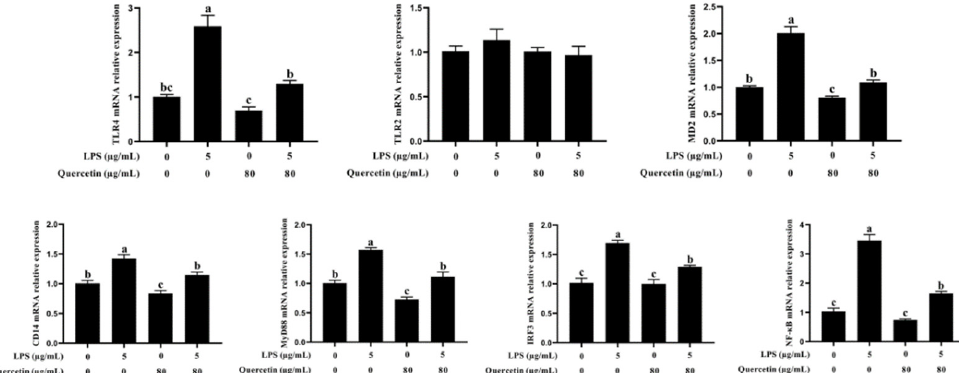
Figure 6. Influence of quercetin on the TLR4 signalling system in LPS-induced BIECs. BIECs were treated with 80 µ g/mL quercetin in an environment of 5 µ g/mL LPS for 6 h. The mRNA expressions of TLR4, TLR2, MD2, CD14, MyD88, IRF3 and NF- κ B in BIECs were tested by qRT-PCR. The results are mean ± SEM (n = 6). Various lowercase letters in the line graph demonstrate significant changes ( p < 0.05).